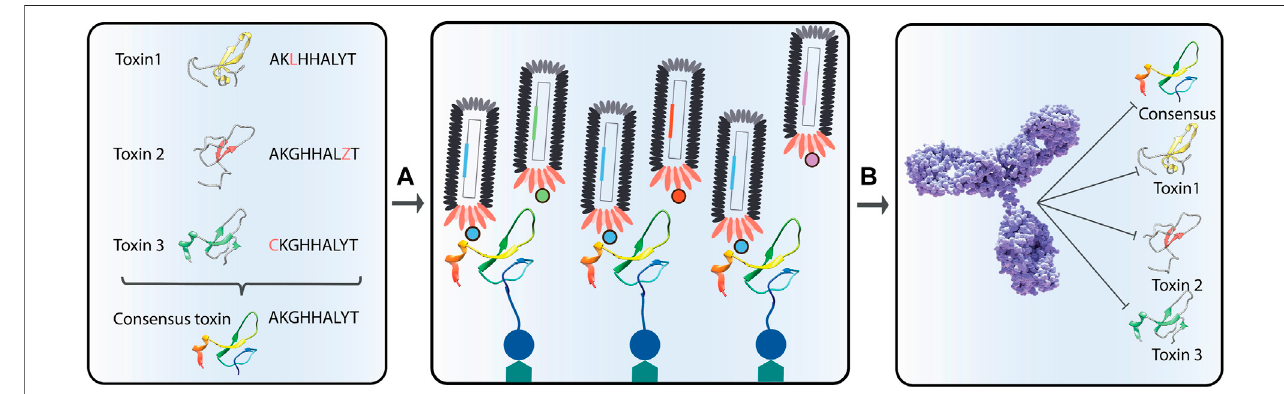
FIGURE 10 | Representation of the discovery of broadly-neutralizing antibodies using consensus toxins. Consensus toxins are designed toxins that represent an average sequence of a collection of homologous toxins (A) . By using consensus toxins in phage display selection campaigns (B) , selected antibodies might be able to neutralize not only the consensus toxin, but also the natural toxins used in the consensus toxin